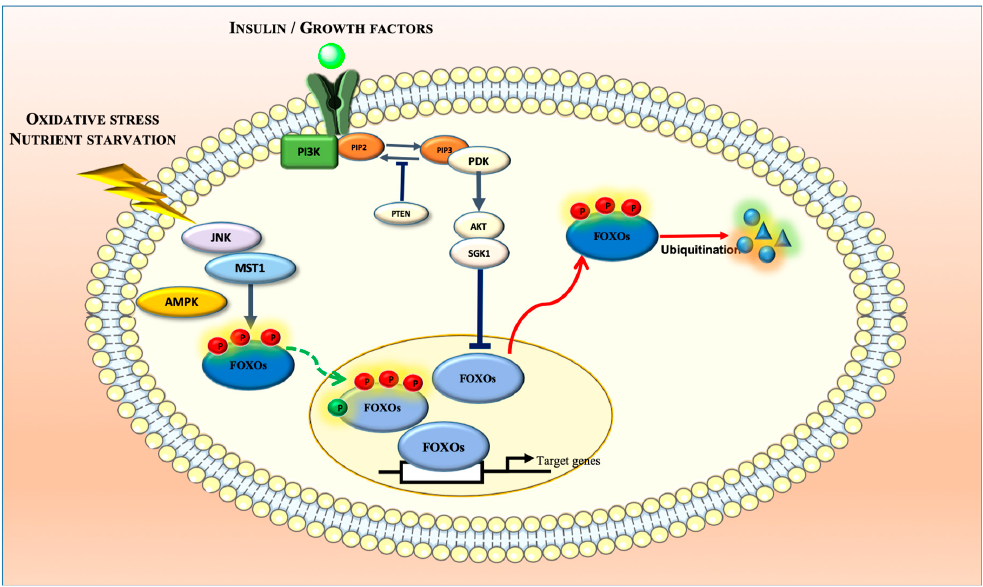
Figure 1. FOXO transcriptional activity is regulated by several upstream regulators that regulate its subcellular localization, thereby controlling the expression of a wide array of genes involved in cellular homeostasis.